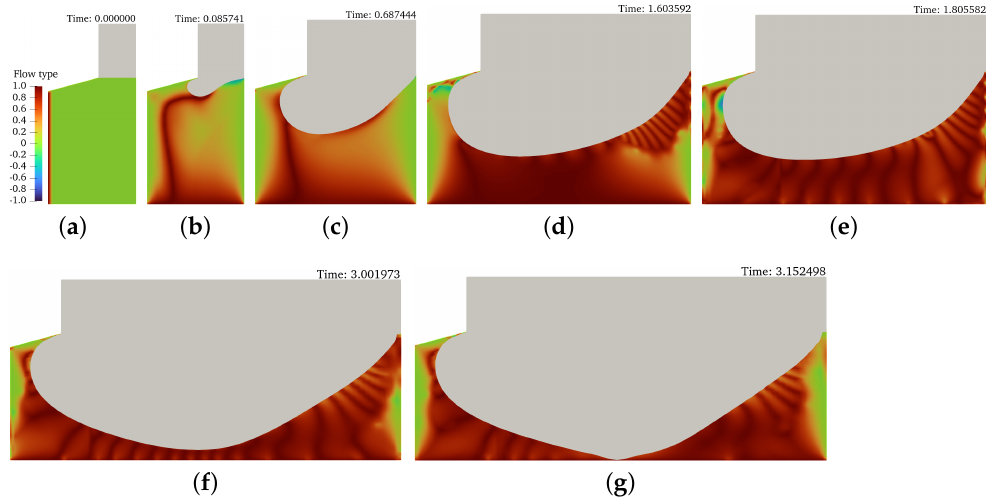
Figure 7. ( a – g ) The contour plots of flow type at different time steps for the simulation of HexaS ink and the gravure velocity U = 2